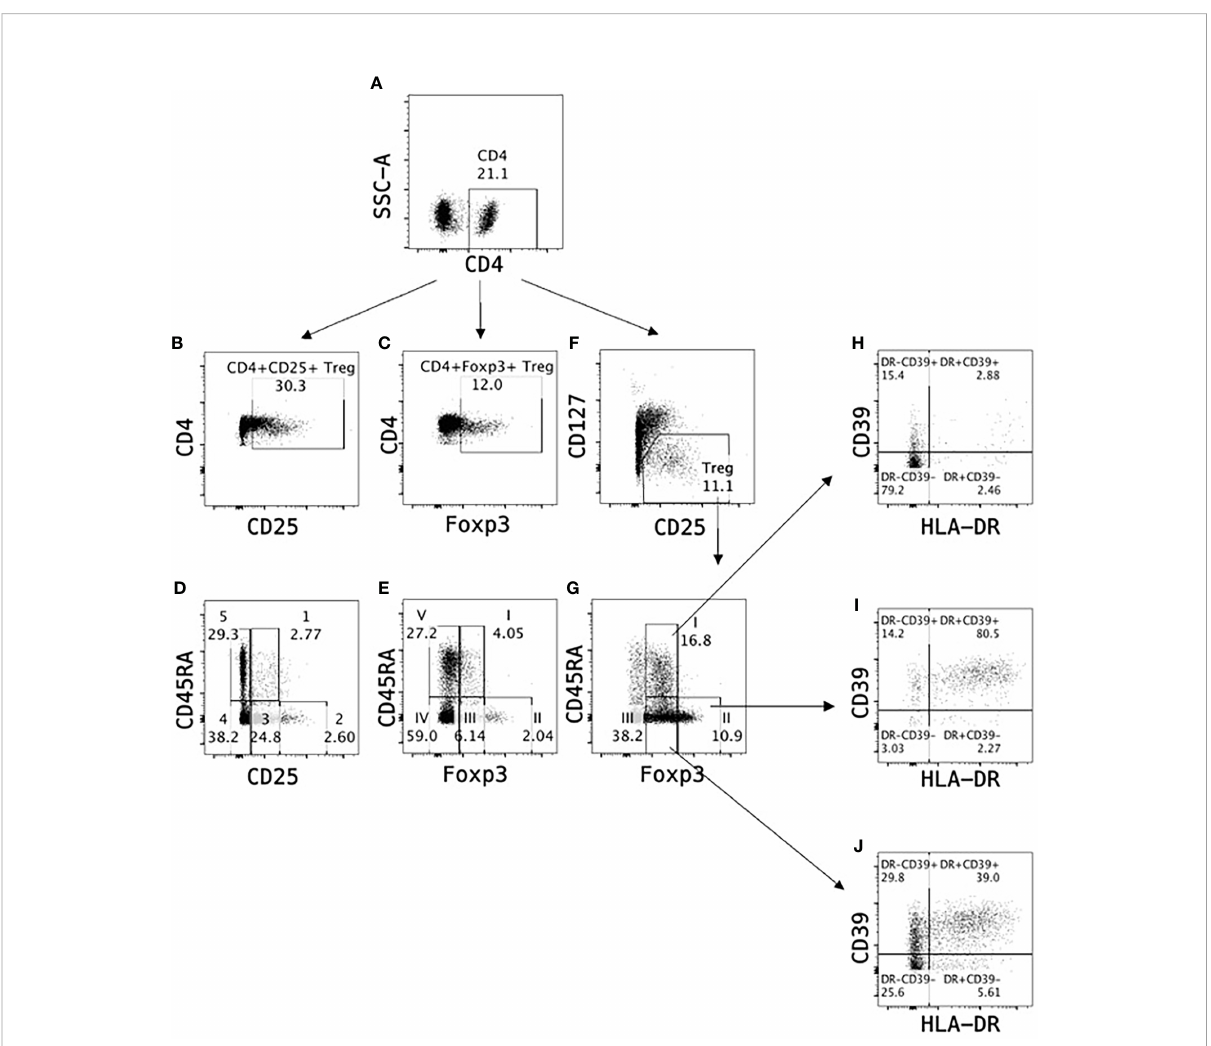
FIGURE 2 Identi fi cation of T regulatory cells in peripheral blood. Treg can be monitored as a proportion of CD4 + cells (A) in peripheral blood based on expression of CD25 (B) or Foxp3 (C) . Alternatively, Treg subpopulations can be identi fi ed as (1) resting Treg CD4 + CD25 + CD45RA + (Population 1 in D ) or CD4 + Foxp3 + CD45RA + (Population I in E ), activated Treg CD4 + CD25 hi CD45RA - (Population 2 in D ) or CD4 + Foxp3 hi CD45RA - (Population II in E ) and non-suppressive cytokine secreting Treg CD4 + CD25 + CD45RA - (Population 3 in D ) or CD4 + Foxp3 + CD45RA - (Population III in E ). A more reliable identi fi cation in human CD4 + cell populations is based on CD25 and CD127 expression where Treg are de fi ned as CD4 + CD25 + CD127 lo (F) , which can further be divided into Treg subpopulations I-III based on Foxp3 and CD45RA expression (G) . Majority of Treg Population II (>80%) express activation markers HLA-DR and CD39 (I) indicating Population II are activated Treg, whereas Population I (H) and Population III (J) contain only <3% and <40% HLA-DR + CD39 + Treg